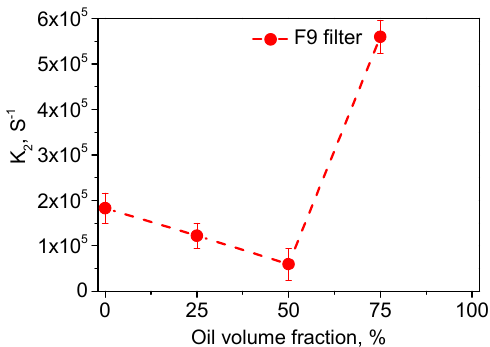
Figure 9. The specific cake resistance K (cid:2870) of clogged F9 filters under different oil-coated particle conditions.